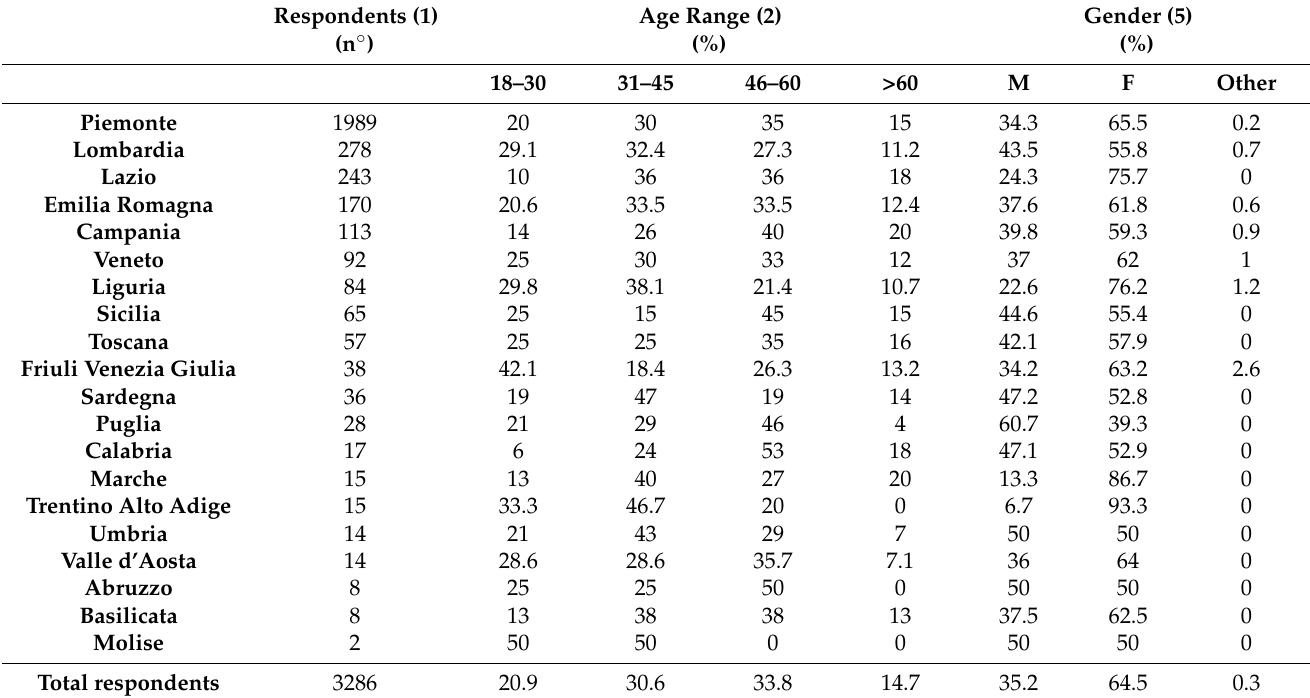
Table 3. Respondent age classes and gender within Italian regions where they spent their social distancing period (questions 1, 2, and 5).